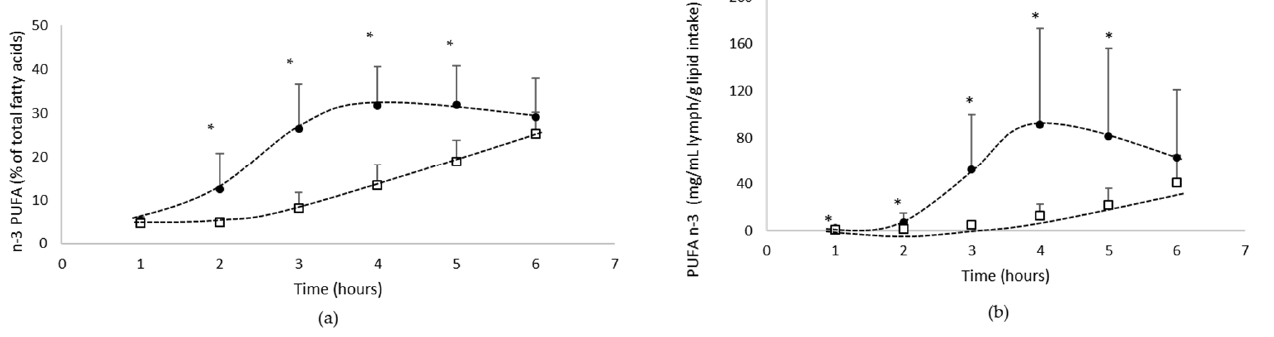
Figure 3. Kinetics of intestinal absorption of n-3 PUFA (( a ): % of total fatty acids and ( b ): mg/mL lymph/g of lipid intake), in rats submitted to a lymphatic duct’s fistula ( n = 8 rats/group) and